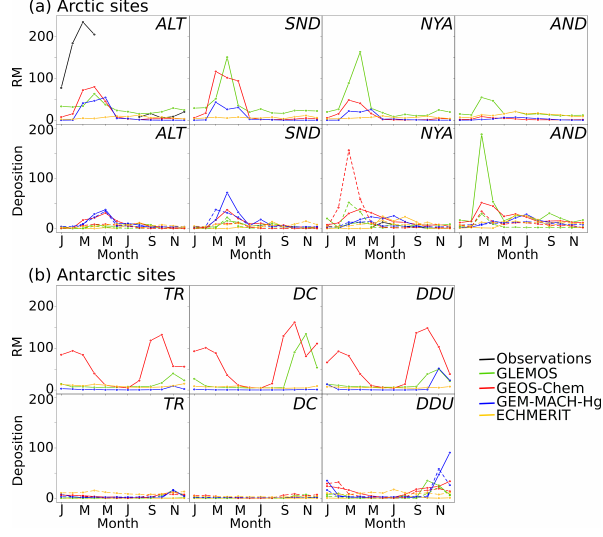
Figure 8. Year 2013 monthly-averaged mean reactive mercury (RM) concentrations (in pgm − 3 ) along with mean wet (solid line) and dry (dashed line) deposition (in ngm − 2 day − 1 ) at (a) Arctic and (b) Antarctic ground-based sites: observations (in black) and concentrations according to the four global models (GLEMOS in green, GEOS-Chem in red, GEM-MACH-Hg in blue, ECHMERIT in yellow). Note that RM (wet deposition) observations are avail- able at ALT (NYA)